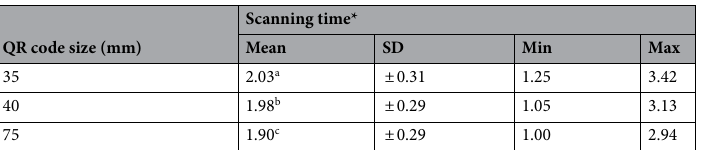
Table 2. Mean, standard deviation (SD) and range of scanning time (s) for three QR code sizes tested (N = 2254). a-c Values with different letters in the column are significantly different (* P < 0.05). *Time interval needed to visualize information encoded to the QR code on the smart glasses M400